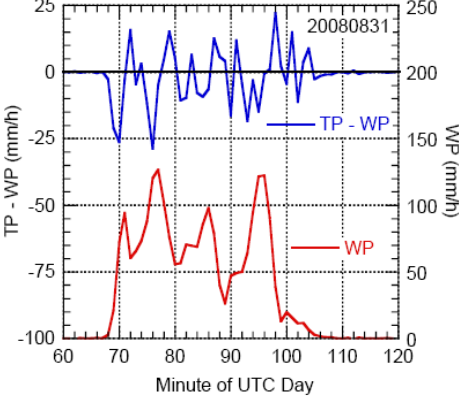
Fig. 10. One-min rain rate differences TP-WP and rain rate from Fig. 10 One-minute rain rate differences TP-WP versus rain rate WP for the event in Fig. WP for the event in Fig. 9. 11